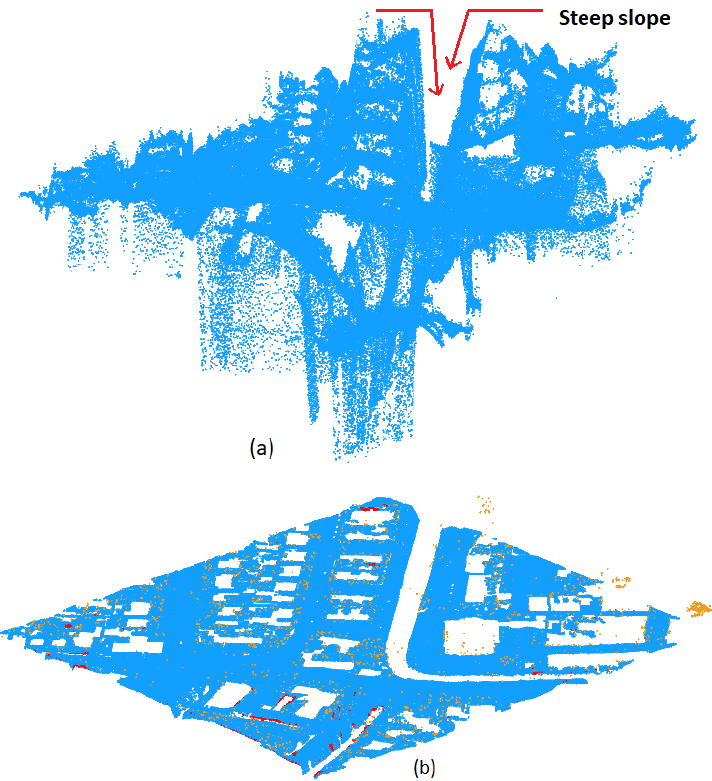
Figure 2. (a) Presence of steep slopes at a drainage system in the terrain, (b) extracted ground surface; ground points (blue), false positives (yellow) and false negatives (red). Radius (cm)